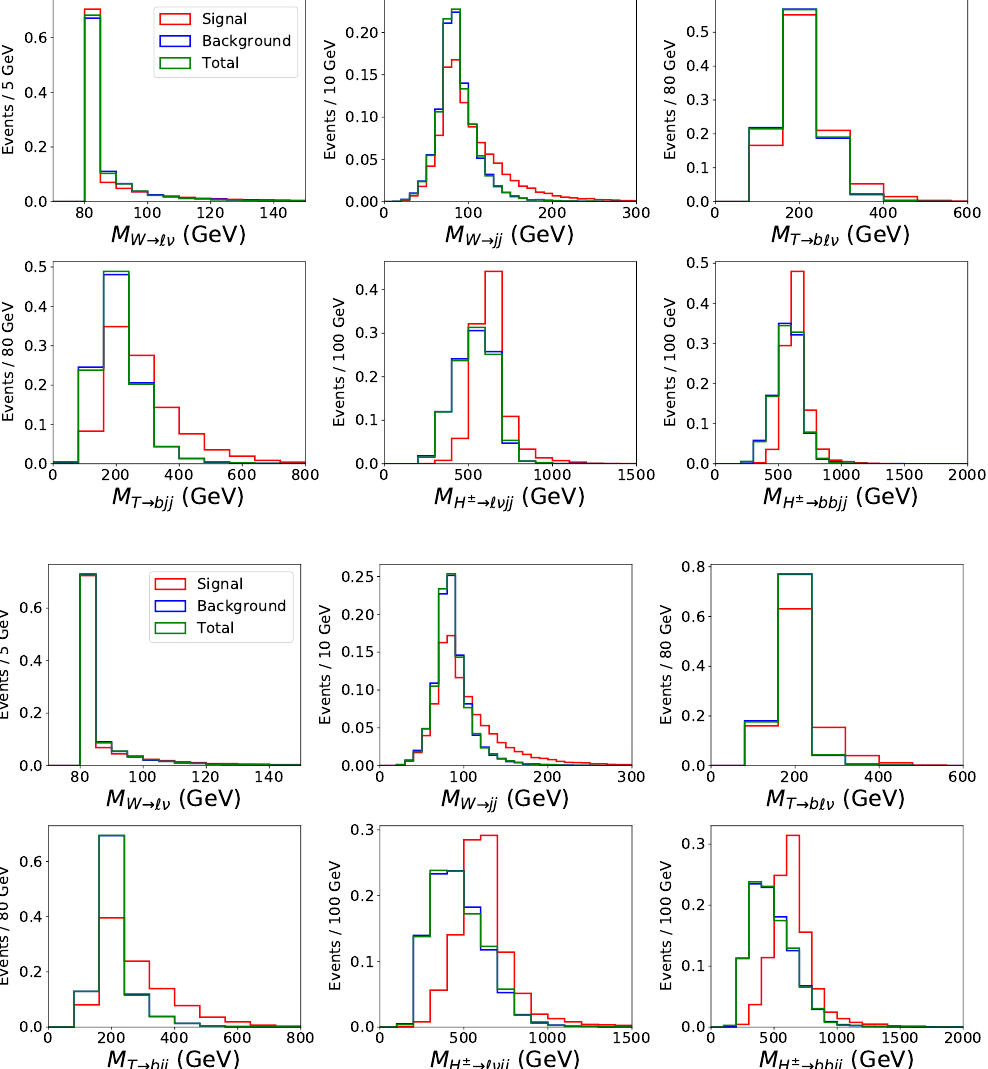
Figure 7 . Invariant mass distributions for reconstructed particles in the h MSSM benchmark. Top: model independent. Bottom: model